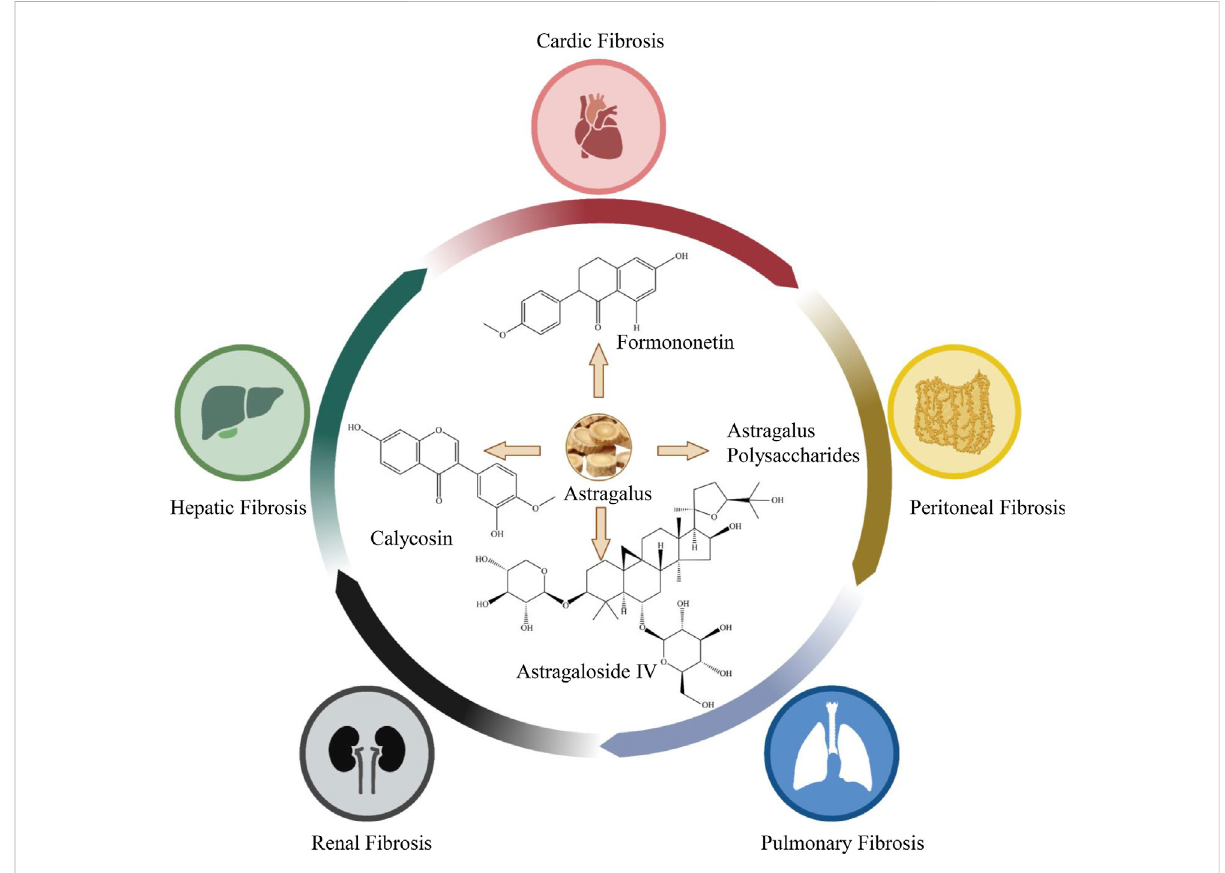
FIGURE 1 Anti fi brosis effects of Astragalus and its main active anti- fi brotic